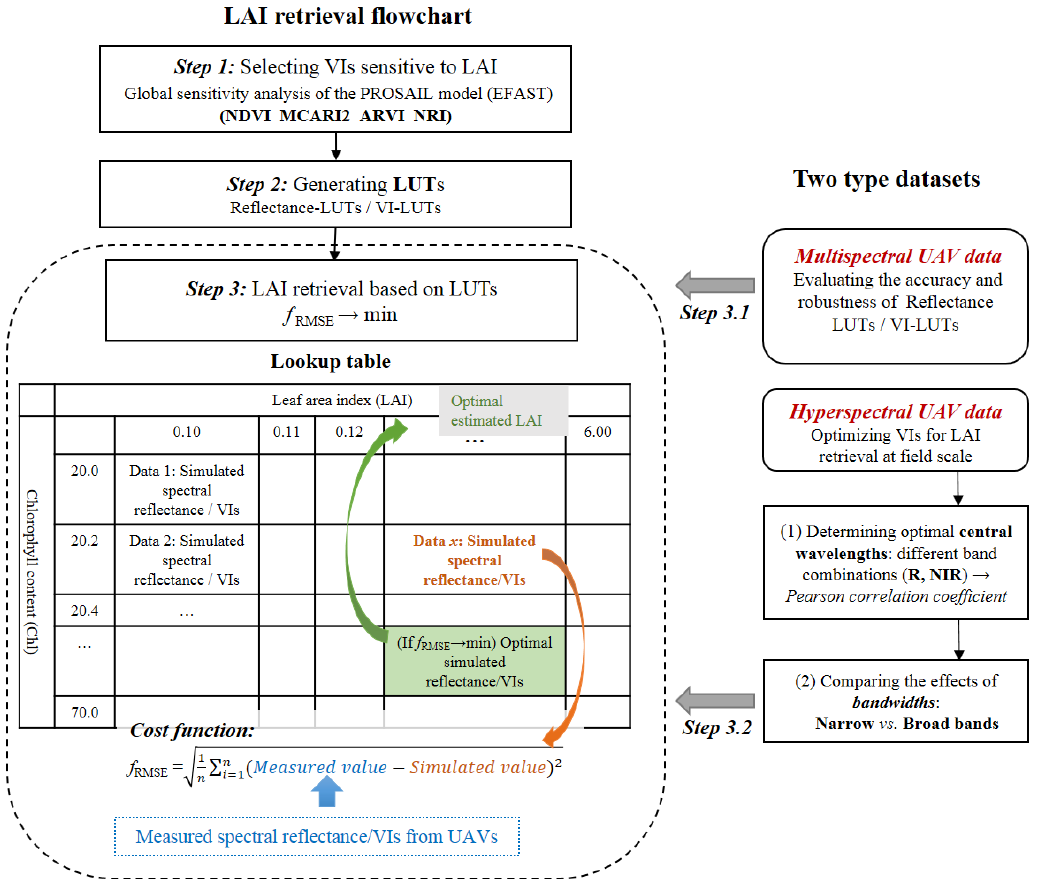
Figure 4. Flowchart of crop LAI retrieval using multispectral and hyperspectral UAV datasets. ARVI = atmospherically resistant vegetation index; MCARI2 = modified improved chlorophyll absorption ratio index; NDVI = modified normalized difference vegetation index; NRI = nitrogen ratio index; NIR = near-infrared band; R = red band; f RMSE = cost function.